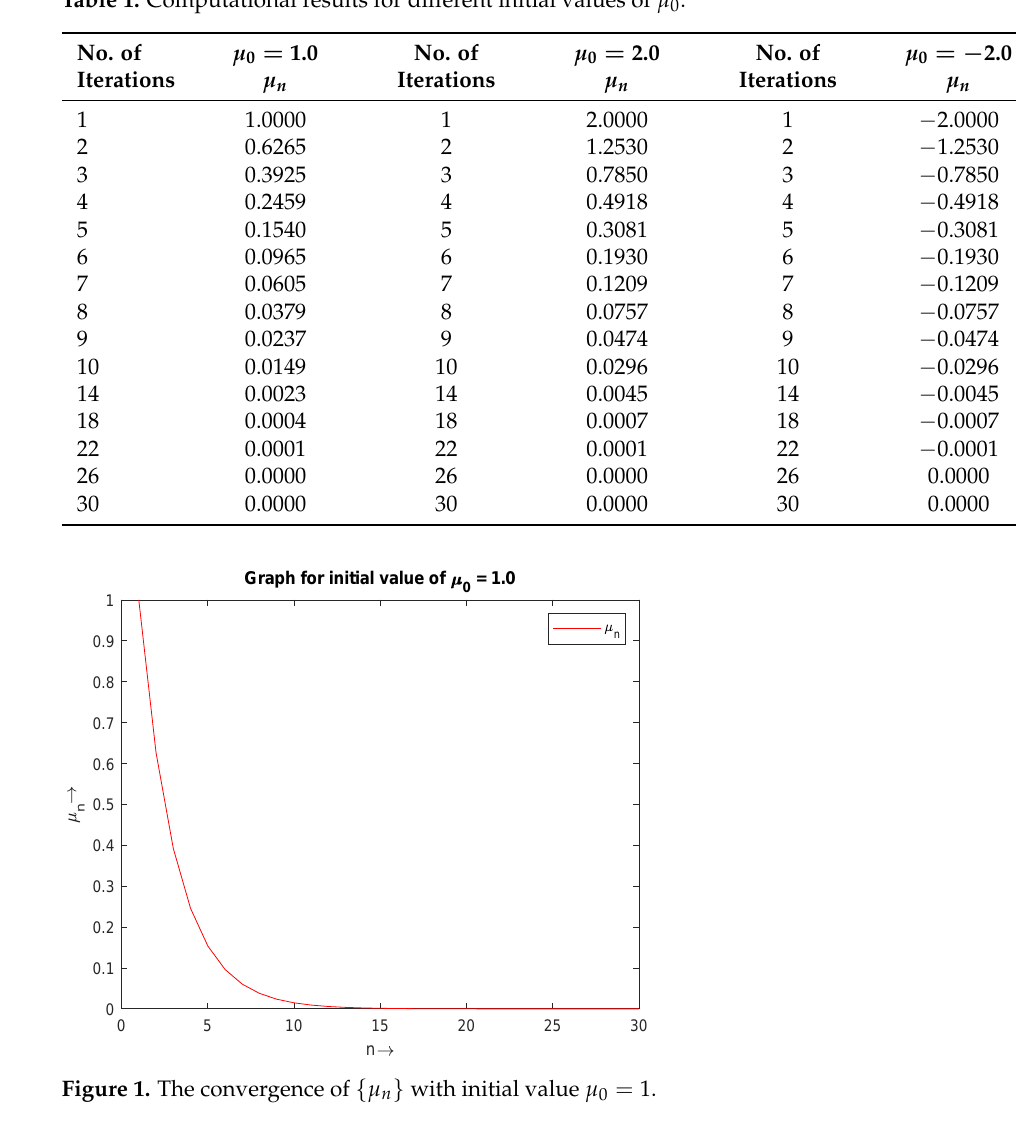
Table 1. Computational results for different initial values of µ 0 .